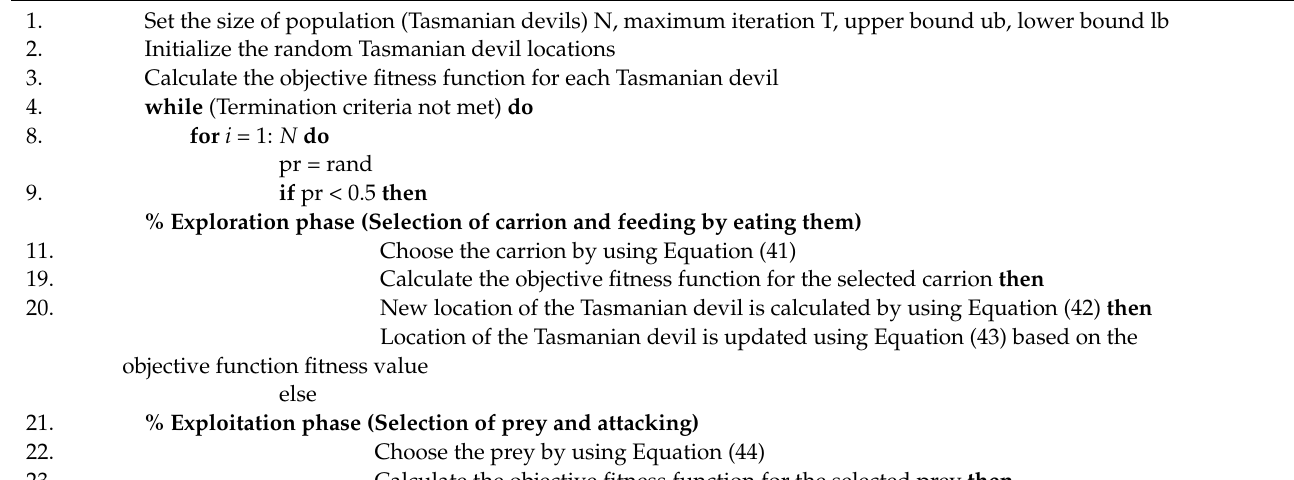
Algorithm A2: Pseudo Code of TDO algorithm